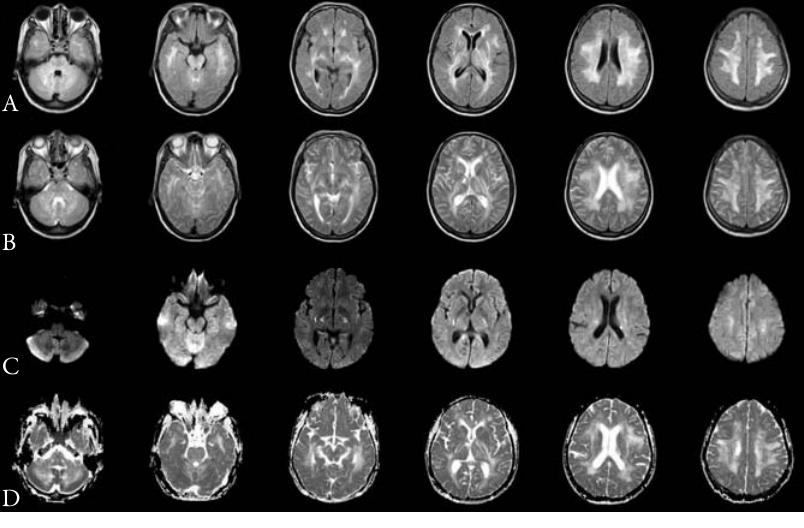
Figure 1. Brain magnetic resonance imaging 46 hours after symptom onset showing hyperintensity involving the periventricular and subcortical deep white matter, the inter- nal capsule, the thalamus, the midbrain, the pons, and the cerebellum bilaterally, on fluid-attenuated inversion recovery (FLAIR) images (A), on T2–weighted images (B), and on apparent diffusion coefficient (ADC) mapping (D). The same lesions showed near isointensity on diffusion-weighted imaging (DWI) (C).